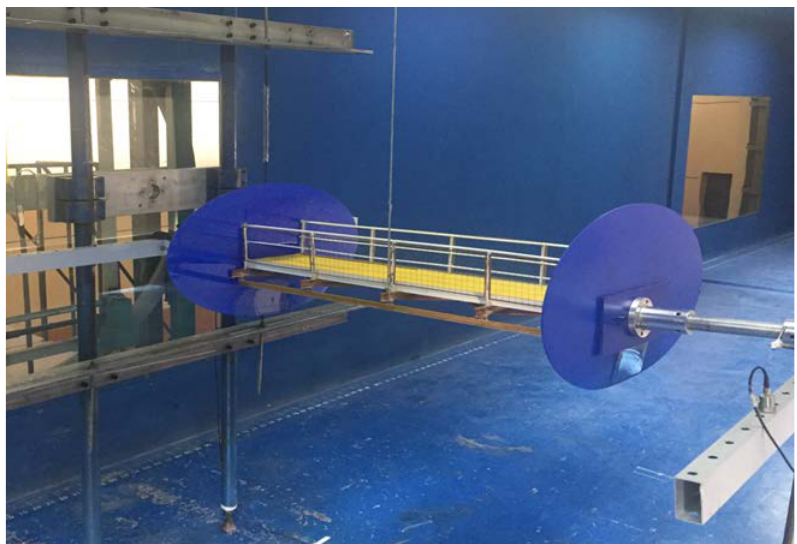
Figure 5. The basic section model in the CA-1 wind